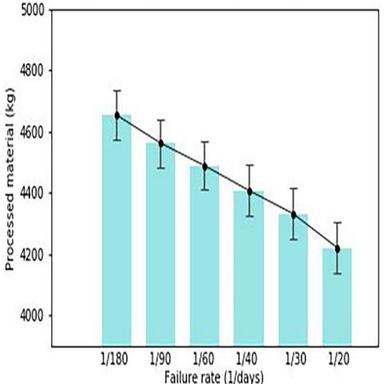
1. With the failure rate parameter of 1/180 days, the average amount of 4653 ± 80.8 kg is processed. The following average amounts given the failure rate parameters of 1/90 days, 1/60 days, 1/40 days, 1/30 days, and 1/20 days are 4561 ± 77.1 kg, 4488 ± 78.9 kg, 4407 ± 82.1 kg, 4332 ± 81.8 kg, and 4221 ± 85.2 kg.